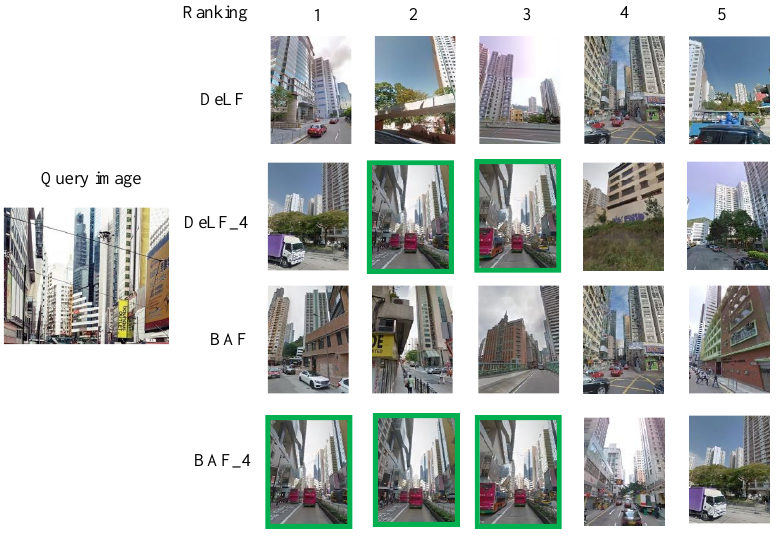
Figure 14. Top5location result ofsame queryimageis usedtoshow